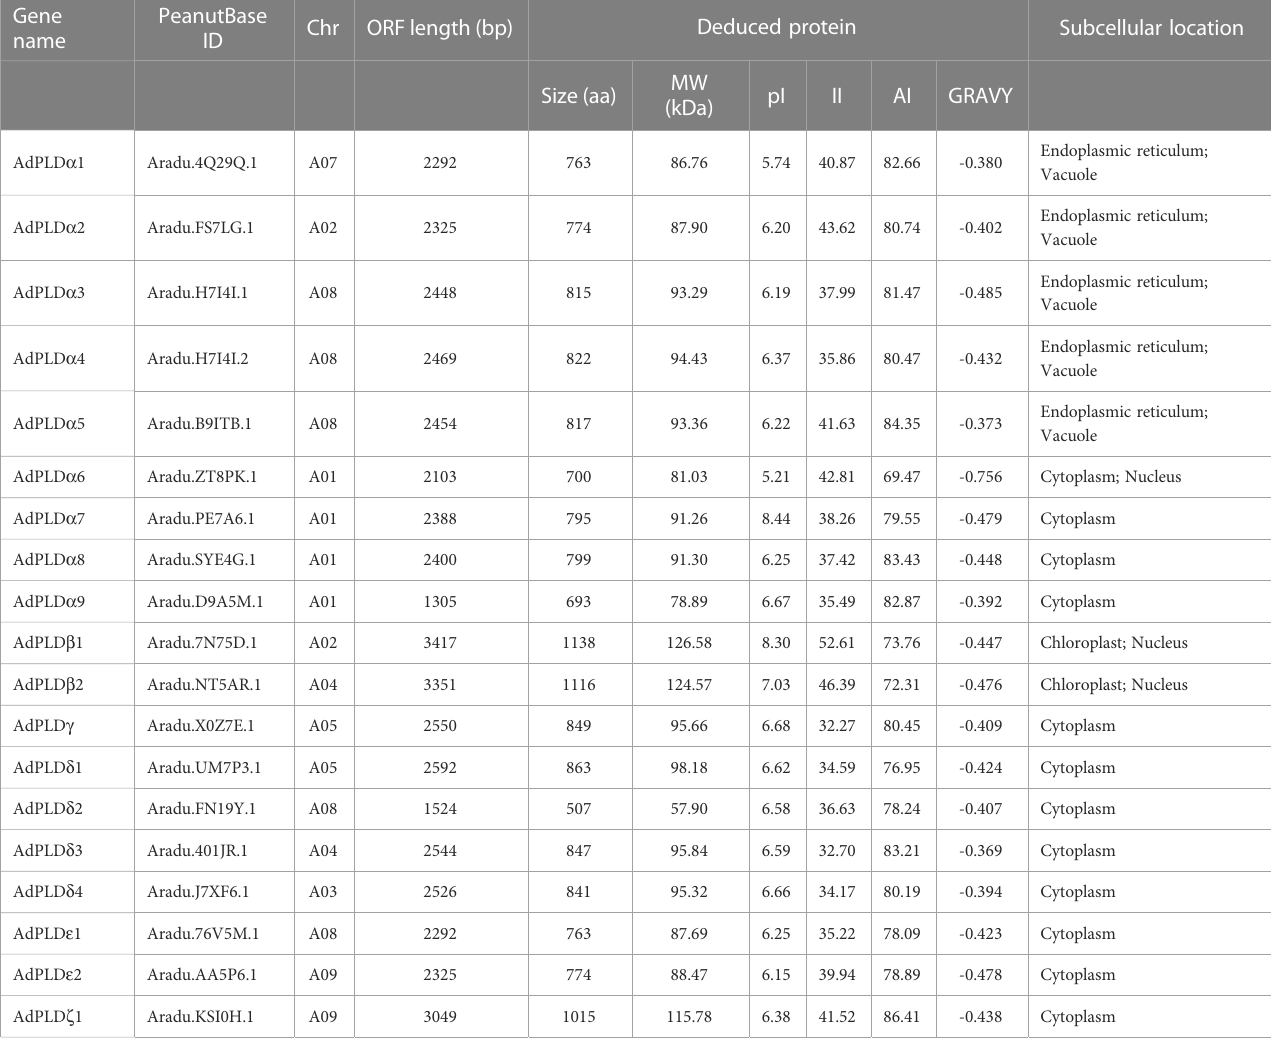
TABLE 1 Detailed information of PLD genes identi fi ed in A. duranensis , A . ipaensis and A . hypogaea